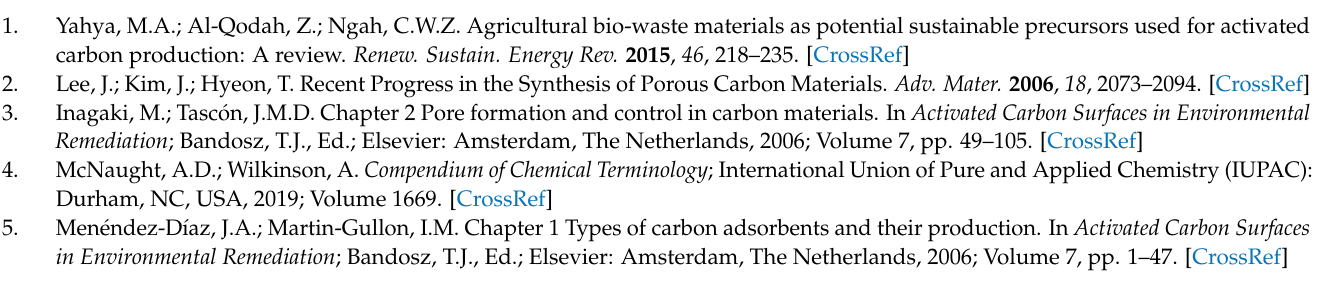
Figure S2: TG plots obtained under air or N 2 of GLU and PMDA; S Langmuir , S BET , S micro , V micro determination